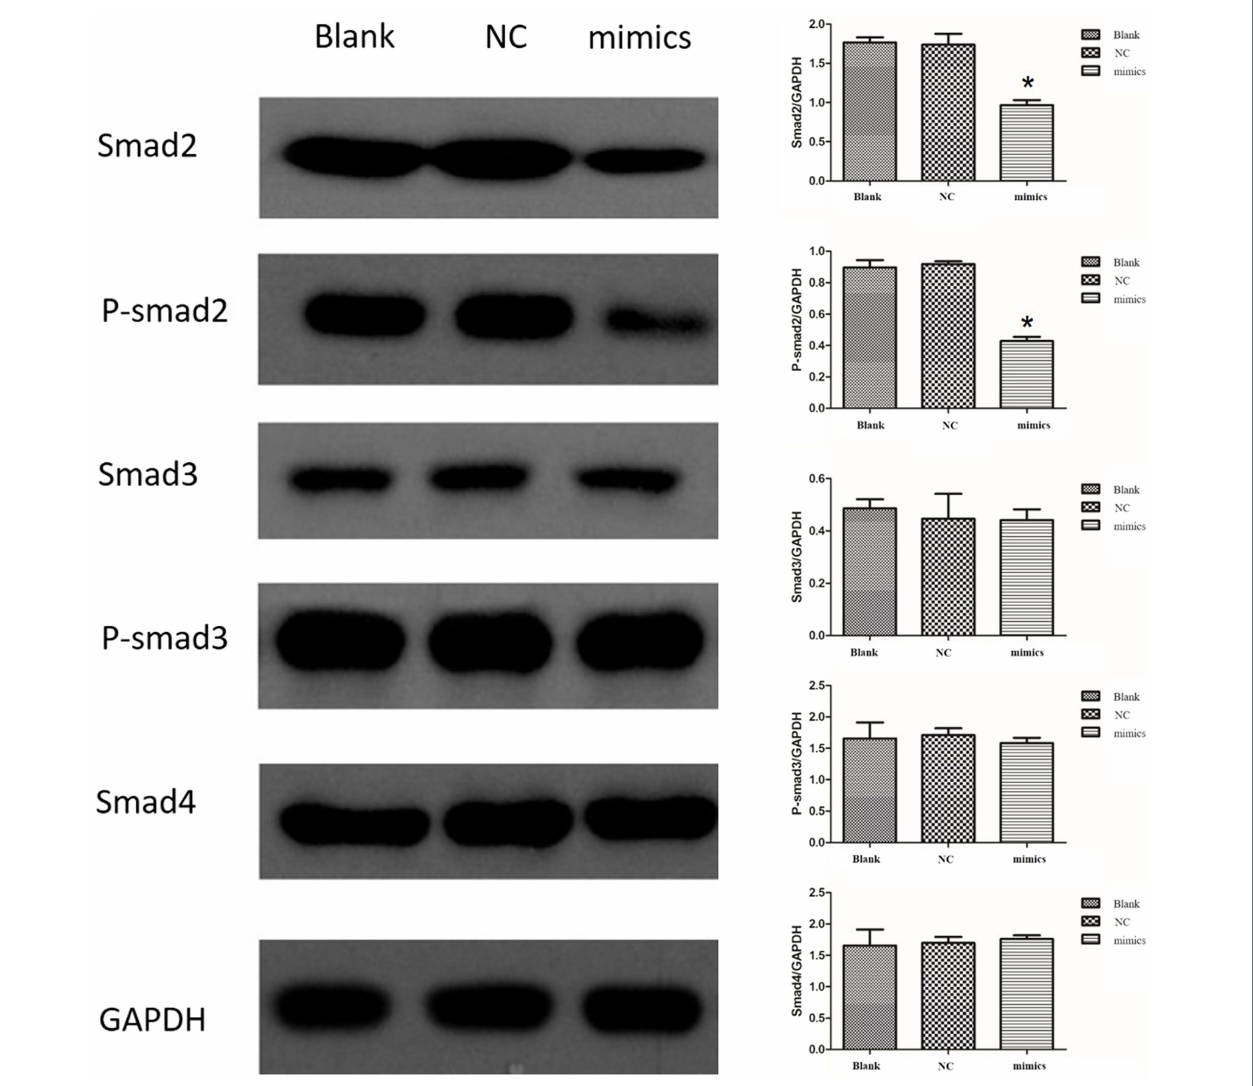
FIGURE 6 | Interaction between miR-423-5p and SMAD2 in vitro. The protein levels of SMAD2 and P-SMAD2 were down-regulated by miR-423-5p mimics, while the levels of SMAD3, P-SMAD3, and SMAD4 were not significantly influenced. * p <